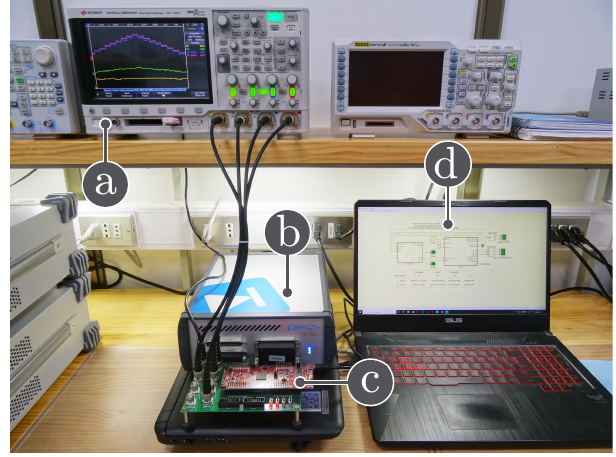
Figure 4. Hardware in-the-loop experimental setup: ( a ) oscilloscope, ( b ) PLECS RT-box, ( c ) Texas Instruments LAUNCHXL-F28069M, ( d ) Laptop.